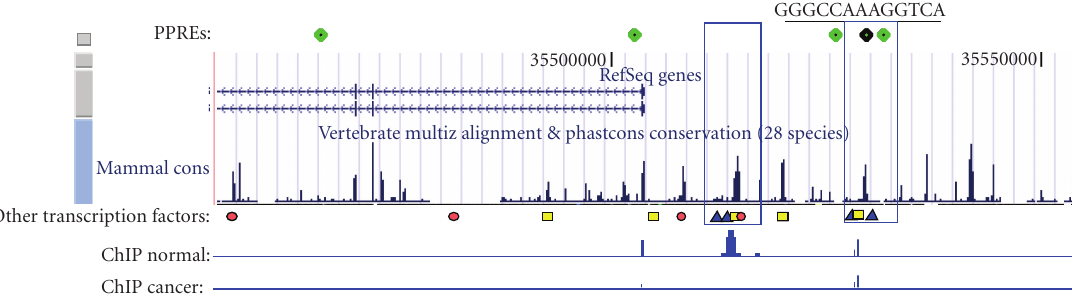
Figure 3: A gene module map compiled from bioinformatics data and experimental datasets. The superimposition of the PPRE track (in green on top) on other genome-wide datasets can reveal promising PPRE-containing binding modules for targeted therapy via PPAR activation. In this imaginary setting, transcription factor 1 (in blue) is known to be one main regulator of the hypothetical gene X and this regulation is altered in cancer. Transcription factor 2 (in yellow) synergistically activates gene X, but is lost in cancer cells. Chromatin immunoprecipitation data comparing normal and cancer binding profiles for this transcription factor reveal two main regulatory modules under normal conditions and a weaker binding in cancer samples due to loss of transcription factor 2. A colocalizing PPRE in module 2 could enable PPARs to replace transcription factor 2 in this module and to restore strong activation of this